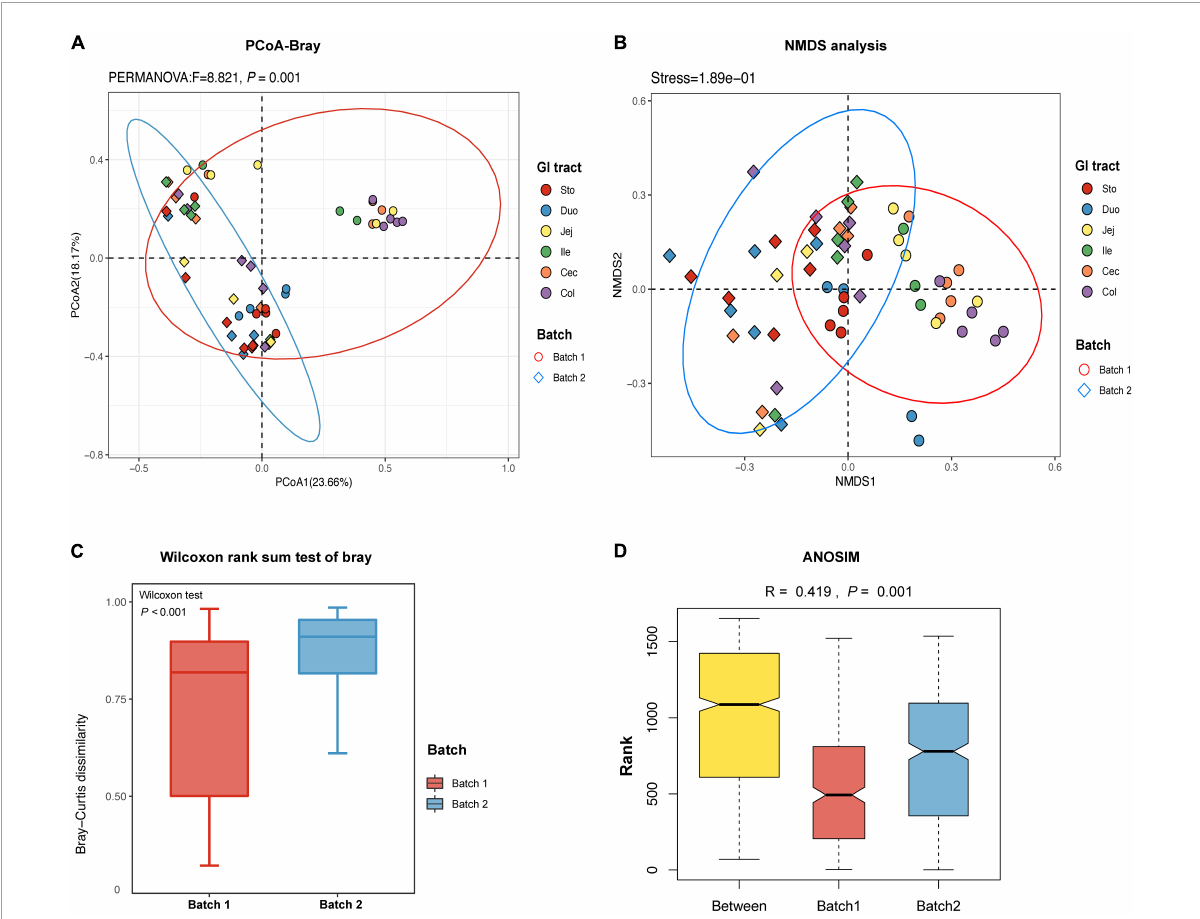
FIGURE2 The β -diversity of fungal community in different regions of the gastrointestinal tract in the pigs. (A) Principal coordinate analysis (PCoA) of Bray-Curtis distances showed the stratification of batch 1 from batch 2 samples by their fungal compositional profiles. (B) Non-metric multidimensional scaling (NMDS) analysis showed that fungal profiles formed two clusters. A stress value less than 0.2 indicates that the model grouping is reliable. (C) Based on the ASVs feature table and Bray-Curtis distances, the Wilcoxon rank sum test is used to identify the significant difference and the degree of difference in fungal microbiome structure within the groups is compared. (D) Based on the distance index ranking, ANOSIM (analysis of similarities) confirmed that the distance between groups is significantly greater than the distance within groups, indicating that the fungal structure of the two batches is significantly different ( R > 0, p < 0.05). Each point represents one sample and colors indicate different GIT regions. Sto: Stomach, Duo: Duodenum, Jej: Jejunum, Ile: Ileum, Cec: Cecum, Col: